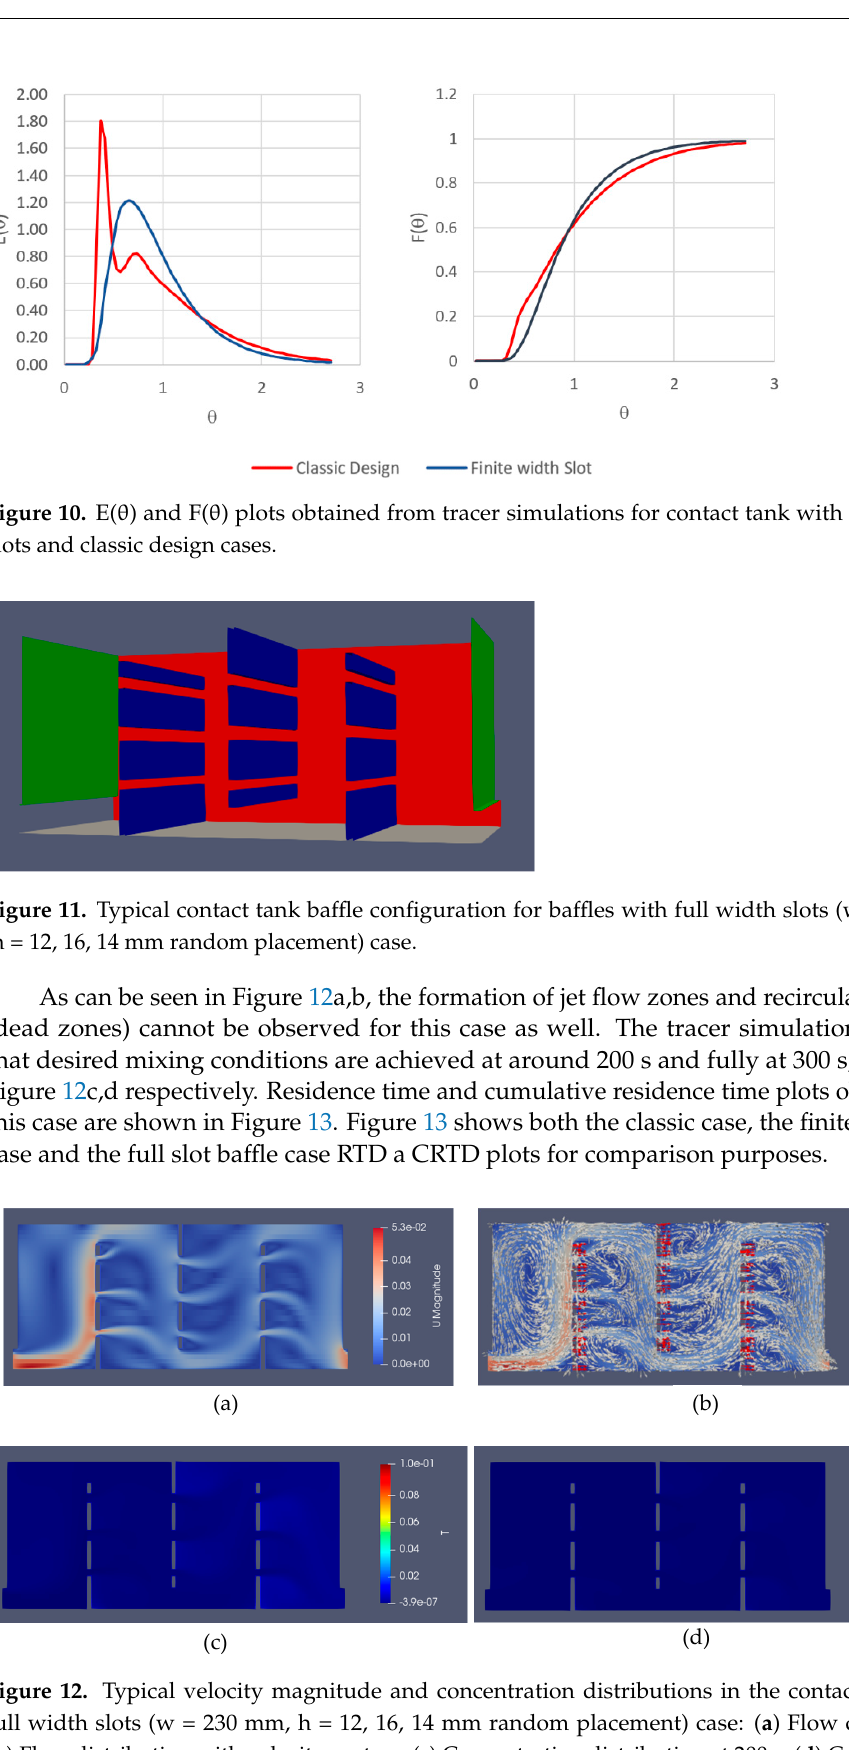
Figure 13. E( θ ) and F( θ ) plots obtained from tracer simulations for contact tank with full width slots (w = 230 mm, h = 12, 16, 14 mm random) case.